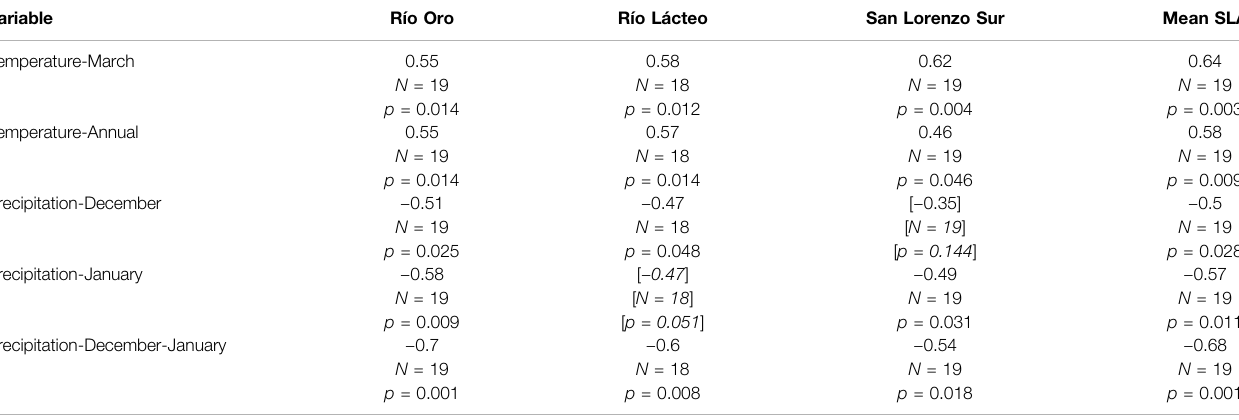
TABLE 4| Correlationmatrix between snowlinealtitude,temperature(March and Annual [December-November] and precipitation(December,January,jointDecember and January) on Balmaceda weather station. Non-signi fi cant r values at p < 0.05 are marked in [ Italics ]. Variable